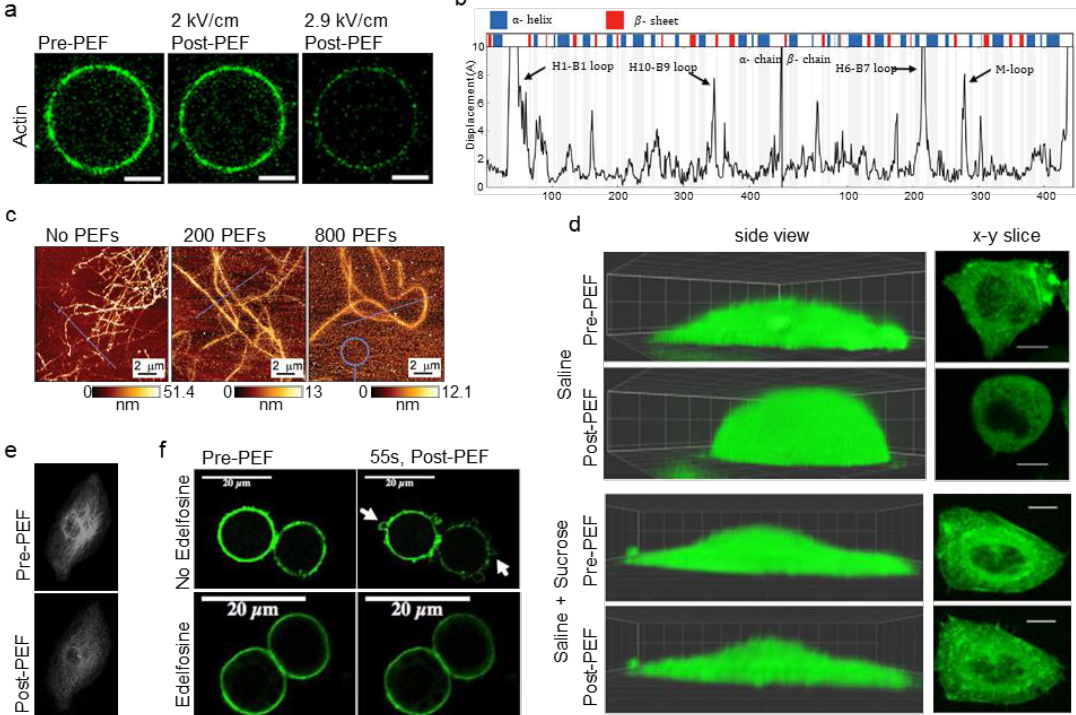
Figure 4. Mechanisms of cytoskeletal disruption. ( a ) Actin-encapsulated GUVs show decreased cortical actin fluorescence after PEF treatment, suggesting direct disruption of actin by electric fields. Scale bars 5 µm. Adapted from [72] . ( b ) Molecular dynamics simulations of tubulin show conformational changes to loops and side chains after nsPEF. Adapted from [84] . ( c ) Atomic force microscopy (AFM) imaging of polymerized, purified MTs after PEF treatment showed a loss of MT cylindrical structure as demonstrated by MT height. Adapted with permission from [81] . ( d ) Inhibiting swelling of Chinese hamster ovary (CHO-K1) cells maintained actin features after 600 ns PEFs (bottom). However, swelling caused a loss of actin structures and led to more homogenous actin structure (top). Scale bars 10 µm. Adapted with permission from [65] . ( e ) Loss of MTs in CHO-K1